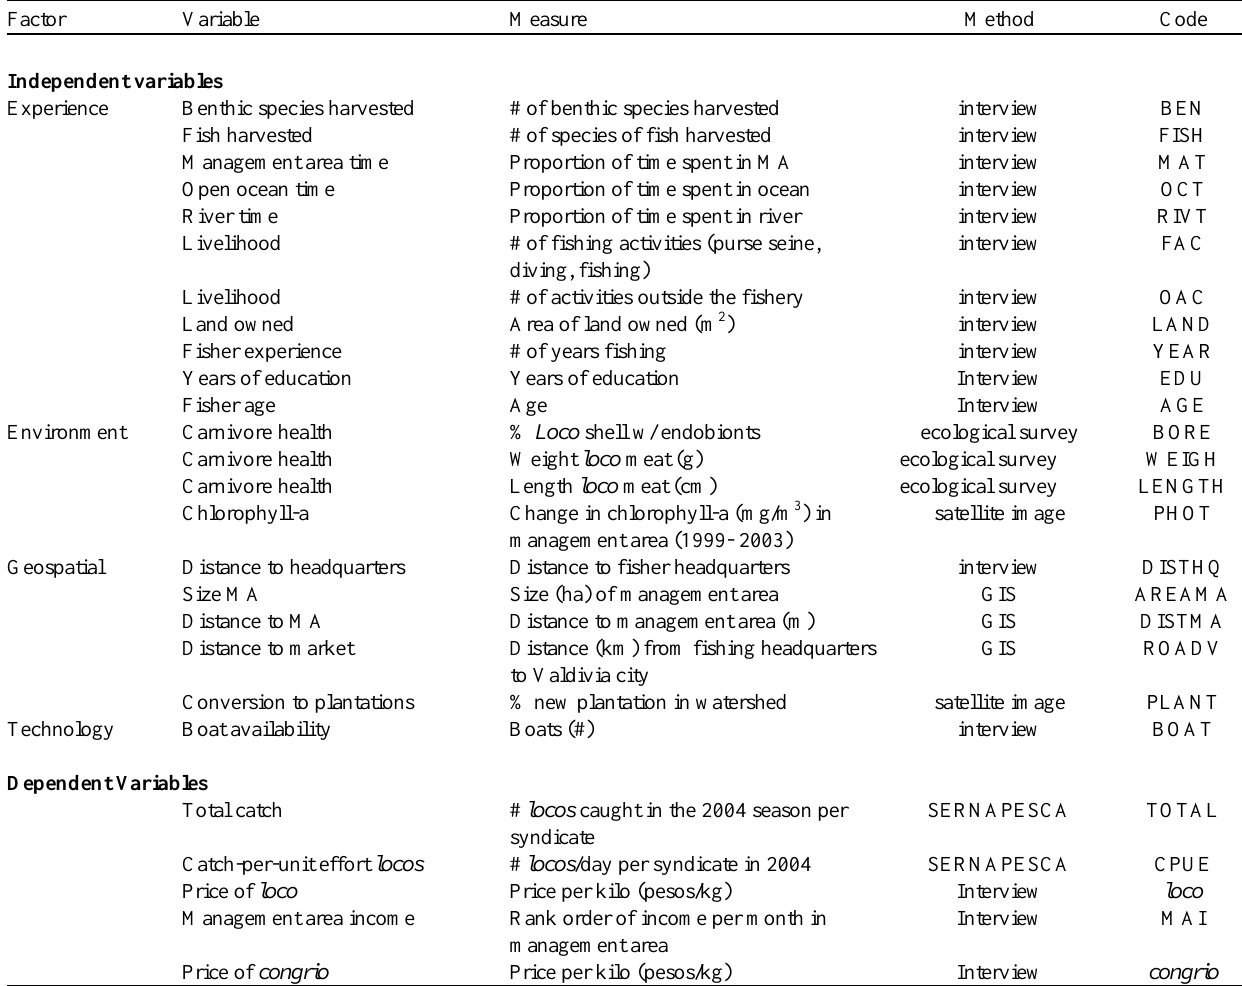
Table 1 . Dependent and independent variables tested in this